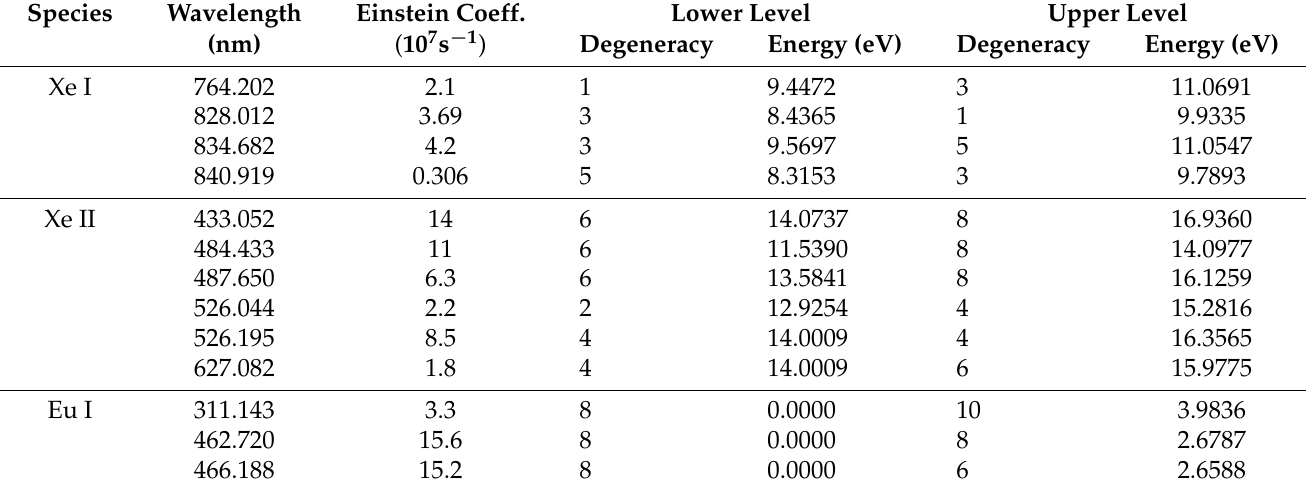
Table 3. Wavelength, transition probability, degeneracy, and upper and lower energy levels of selected Xe and Eu transitions